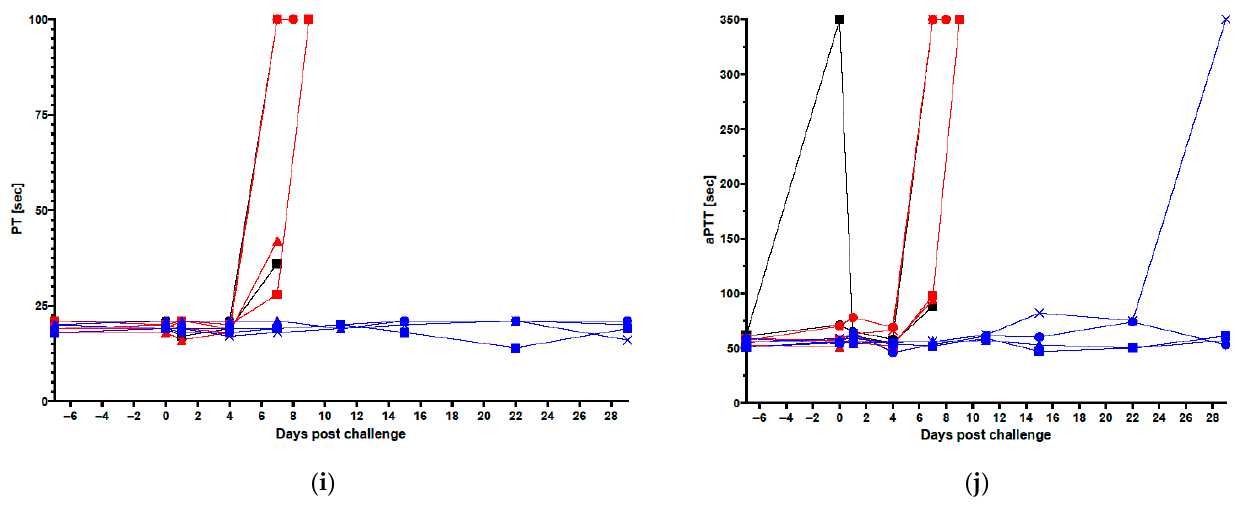
Figure 1. Experimental design, post-challenge survival results and clinical pathology results for control and vaccinated animals. ( a ) experimental design, immunization and bleeding schedule; ( b ) post-challenge survival results; ( c ) ALP, reference interval, 11.34–308.38 U/L; ( d ) ALT, reference interval, 14.16–97.50 U/L; ( e ) PLT, reference interval, 83.48–1009.07 K/µL; ( f ) BUN, reference interval, 7.58–24.40 mg/dL; ( g ) ALB, reference interval, 3.55–5.81 g/dL; ( h ) CRP; ( i ) PT, reference interval, 14.40–27.27 s (sec); ( j ) aPTT, reference interval, 31.12–92.66 s. All reference intervals are the values spanning 95% of the lower bound and 95% of the upper bound. Reference intervals were determined based on healthy rhesus and cynomolgus macaques at Texas Biomedical Institute. 1E11 vp animals are shown in blue. 1E6 vp animals are shown in red. Saline control animals are shown in black. Survival data are graphed by group using corresponding colors. NHP1 of each group is shown as a circle, NHP2 is shown as a square, NHP3 is shown as a triangle and NHP4 is shown as an “×”. The following animals were found dead in cage (FDIC): NHP4, 1E6 vp (FDIC on day 9 post-challenge; last sample collection was day 7 post-challenge) and NHP2, Saline (FDIC on day 9 post-challenge; last sample collection was day 7 post-challenge). Blood was not collected on the day the animals were FDIC. Two animals that survived to the scheduled end of project were euthanized on day 29, and two others were euthanized on day 32. Data for all four surviving animals are depicted on day 29.